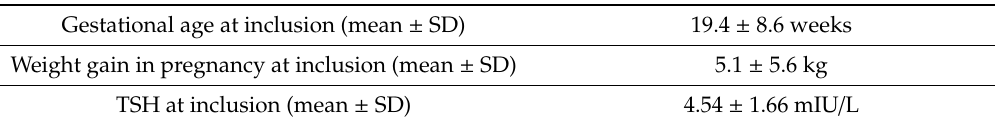
Table 1. Characteristics of the study